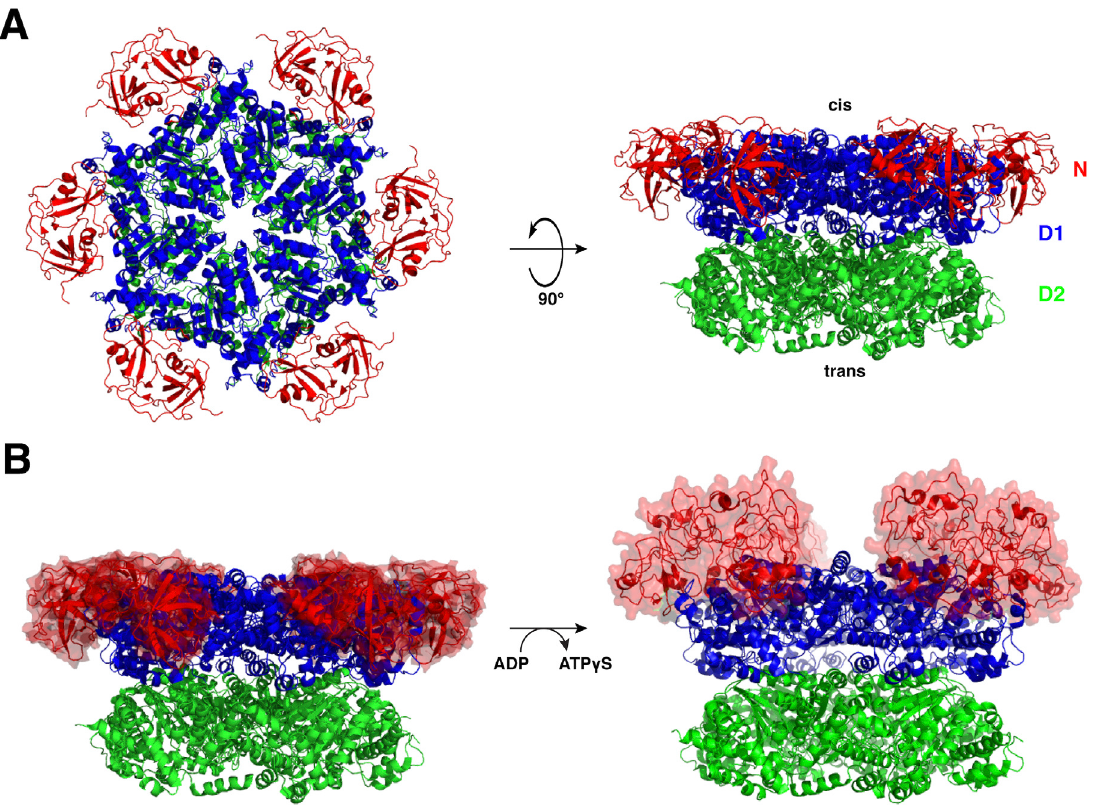
Figure 1. Structure of the Cdc48/p97 ATPase. ( A ) Cdc48 is a homohexamer, and each monomer comprises an N-terminal (N) domain (red) and two AAA ATPase domains: D1 (blue) and D2 (green). The N-terminal (D1) side of the central pore is referred to as the cis side, and the C-terminal (D2) side as the trans side. ( B ) ATP binding produces an upward rotation of the N domains into a so-called “up conformation”, in which they are positioned above the plane of the D1 ring. Left, ADP-bound state (PDB code 5FTK); right, ATP γ S-bound state (PDB code 5FTN). PDB, Protein Data